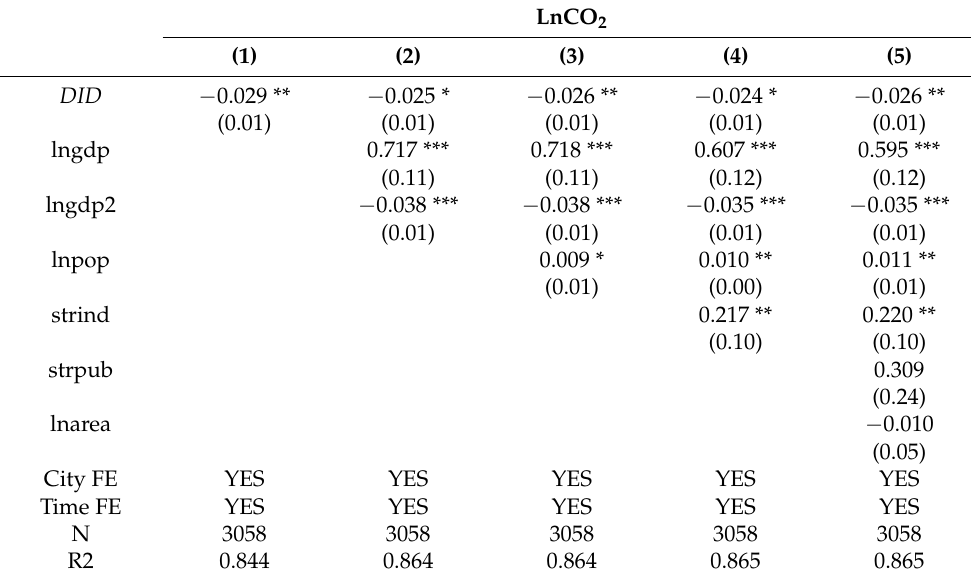
Table 3. Impact of LCCP on carbon emission.